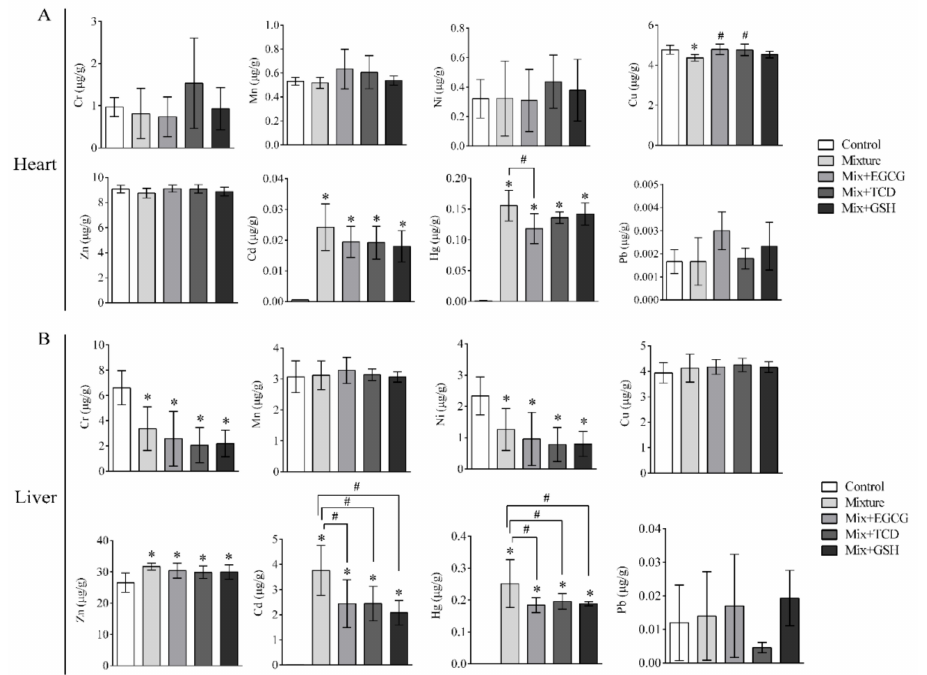
Figure 3. Contents of eight heavy metals in the heart and liver. ICP-MS was carried out after histopathological examination. Bars represented contents of eight heavy metals (ug) in per gram of organs; ( A ) Contents of eight heavy metals in the heart of SD rats; ( B ) Contents of eight heavy metals in the liver of SD rats; n = 6 rats / each group; Results were presented as means ± SD; One-way ANOVA and LSD-t test were showed; * p < 0.05, vs. the control group (Mixture, Mix + EGCG, Mix + TCD, Mix + GSH compared with the control group); # p < 0.05, vs. the Mixture group (Mix + EGCG, Mix + TCD, Mix + GSH compared with the Mixture group); Mix,